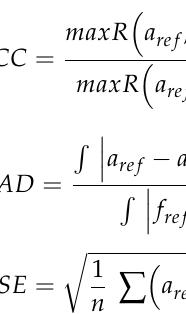
Table 3. Comparison of the MCAs for the WLTC driving cycle.